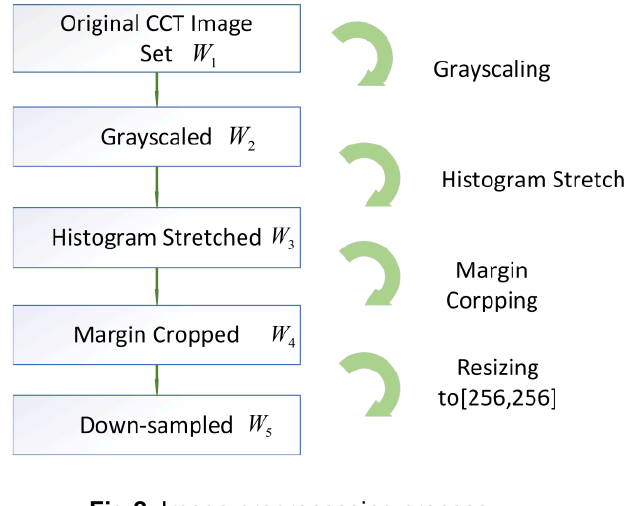
Fig 2. Image preprocessing